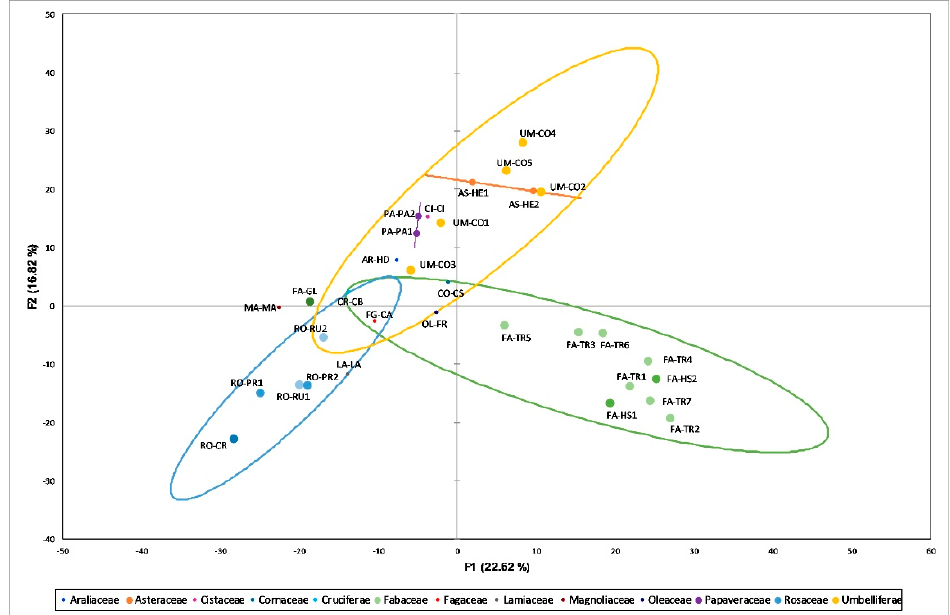
Figure 4. Score plot of the first two components obtained by PCA performed on data set incorporating all pollen samples and color coordinates (L*, a* and b*), granulometry and second derivative IR data (1800–650 cm − 1 ) as variables. The botanical origin (family) was used as passive variable to represent ellipses corresponding to 80% confidence interval for a bivariate normal distribution with the same means and the same covariance matrix as the factor scores for each group.